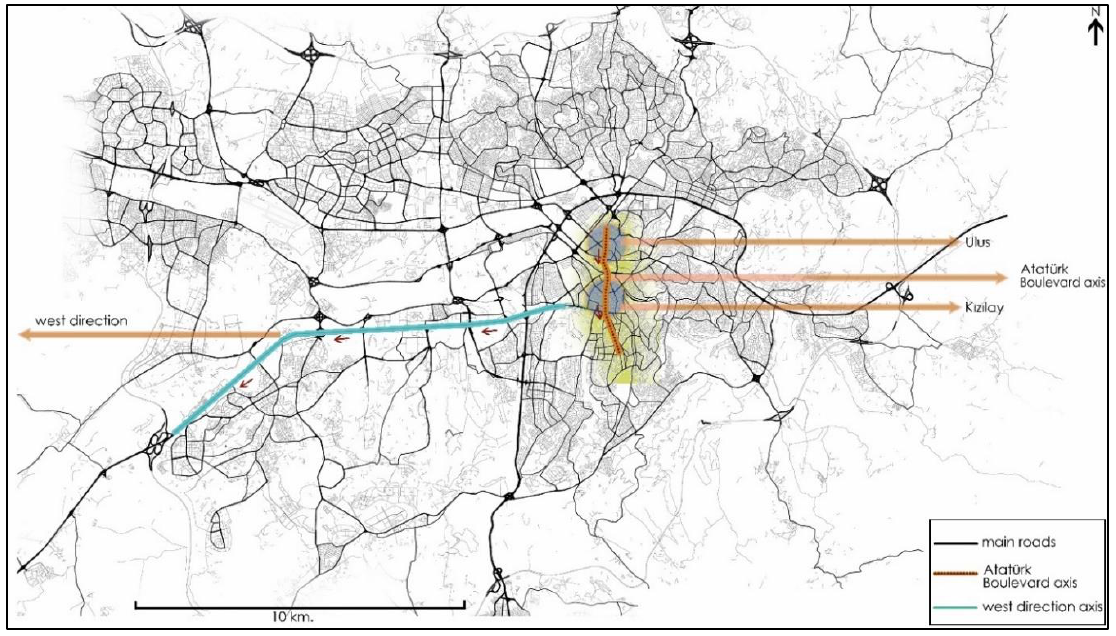
Figure 17 The evaluation of Ankara’s current